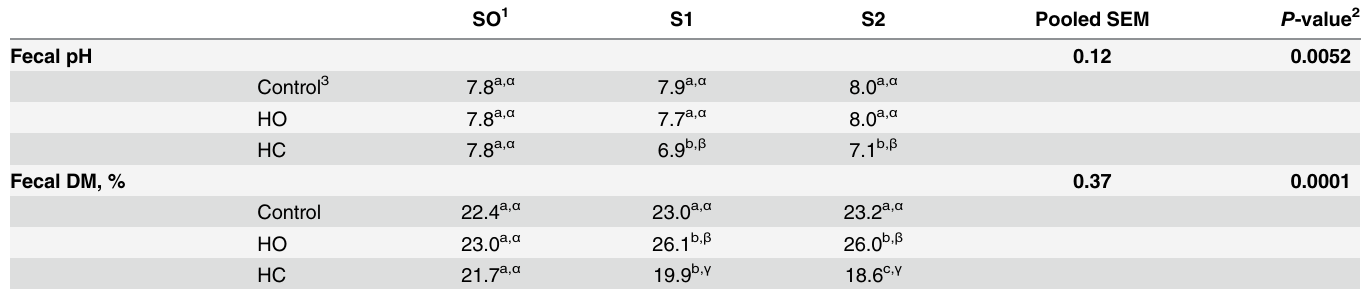
SO 1 S1 S2 Pooled SEM